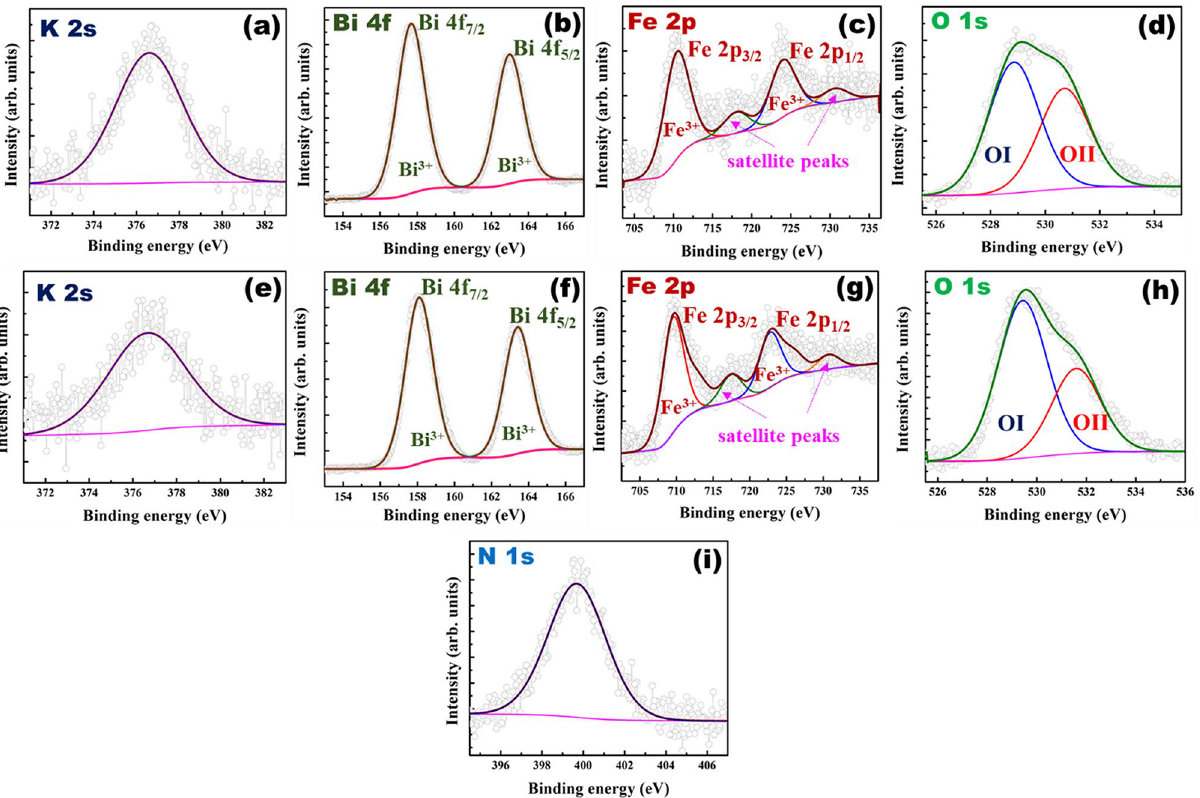
Figure 3. X-ray photoelectron spectra and the corresponding fits belonging to KBFO and 20 N-KBFO samples: ( a – d ) K 2s, Bi 4f, Fe 2p, and O 1s corresponding to KBFO ( e – i ) K 2s, Bi 4f, Fe 2p, O 1s and N 1s corresponding to